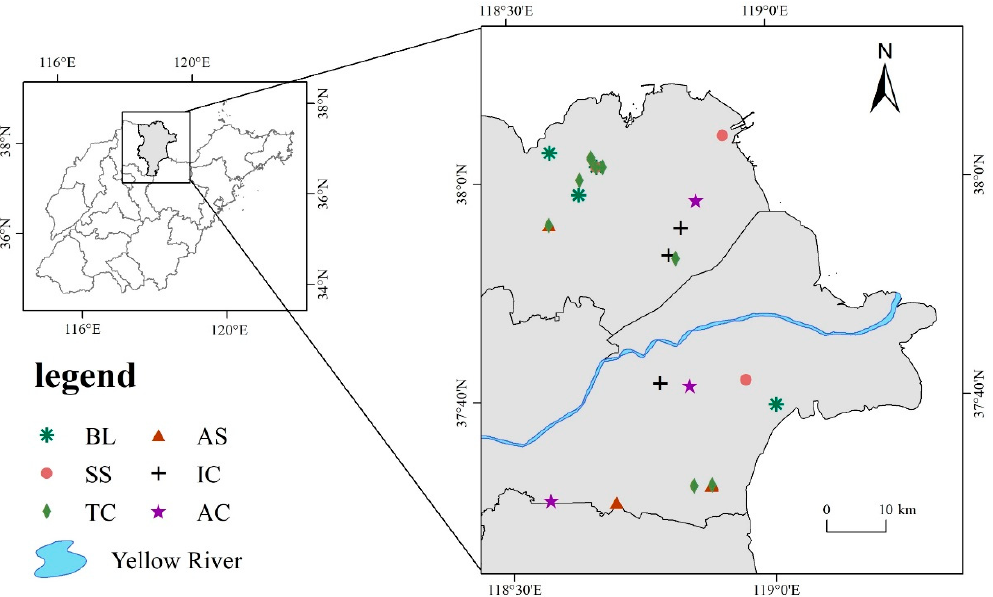
Figure 1. Sampling site in the Yellow River Delta; BL stands for the soil of bare land, SS stands for the soil of Suaeda salsa (L.) Pall., TC stands for the soil of Tamarix chinensis Lour., AS stands for the soil of Aeluropus sinensis (Debeaux) Tzvel., IC stands for the soil of Imperata cylindrica (L.) Beauv., and AC stands for the soil of Artemisia capillaris Thunb., the same is represented below.